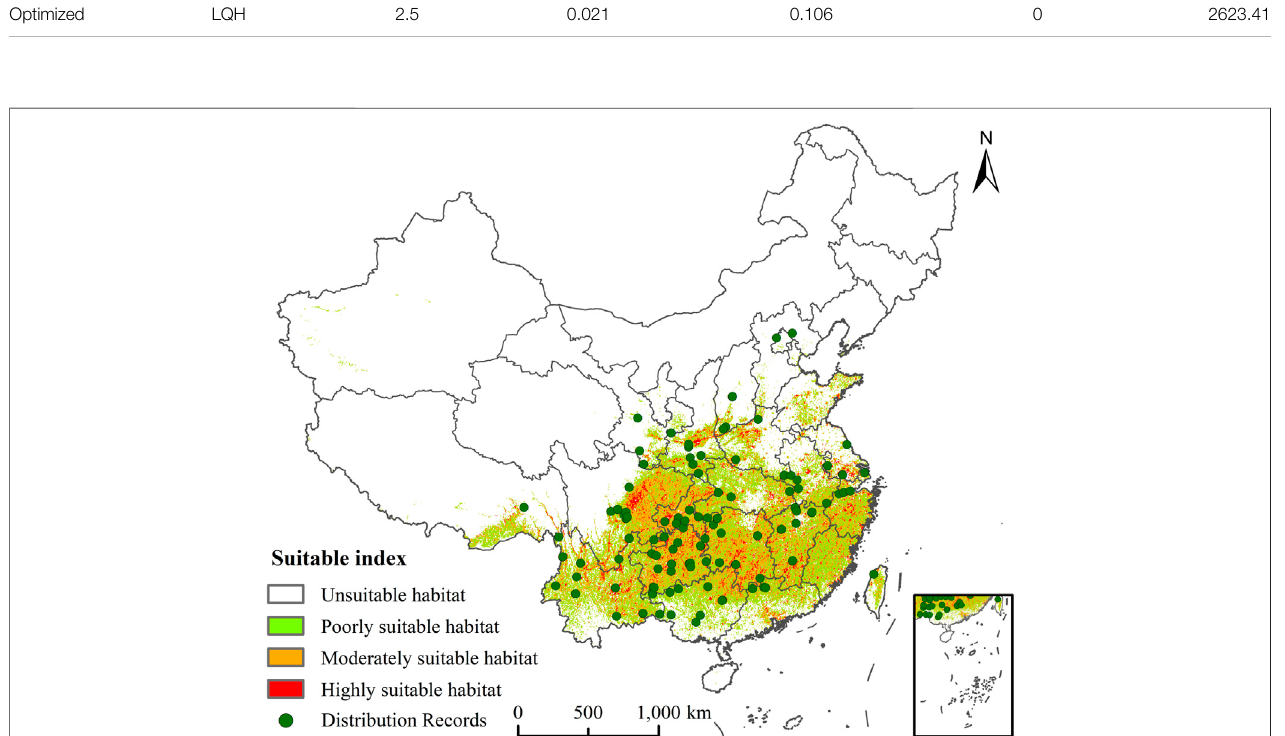
FIGURE 2 | Distribution of the occurrence of Cremastra appendiculata in